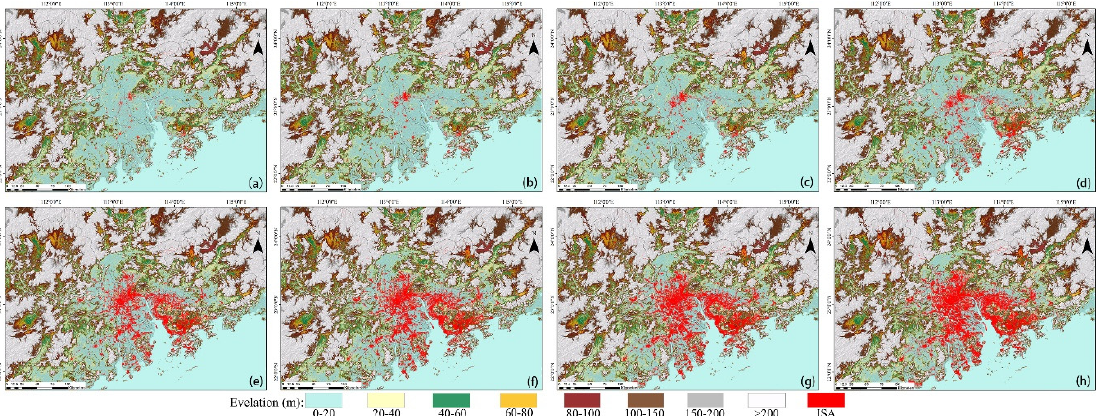
Figure 10. The ISA distribution at different elevation levels ( a ) 1994; ( b ) 1997; ( c ) 1999; ( d ) 2003; ( e ) 2006; ( f ) 2010; ( g ) 2013, and ( h ) 2016.